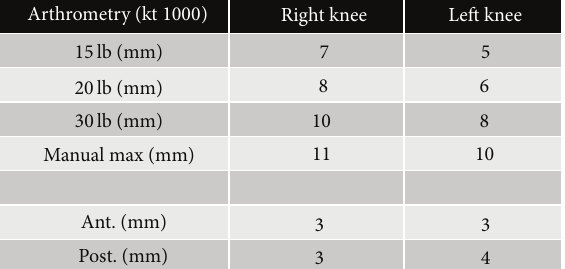
Figure7:Biomechanicalevaluationpost-op.Thenewbiomechanics created in the knees is similar to a normal knee with intact native cruciate